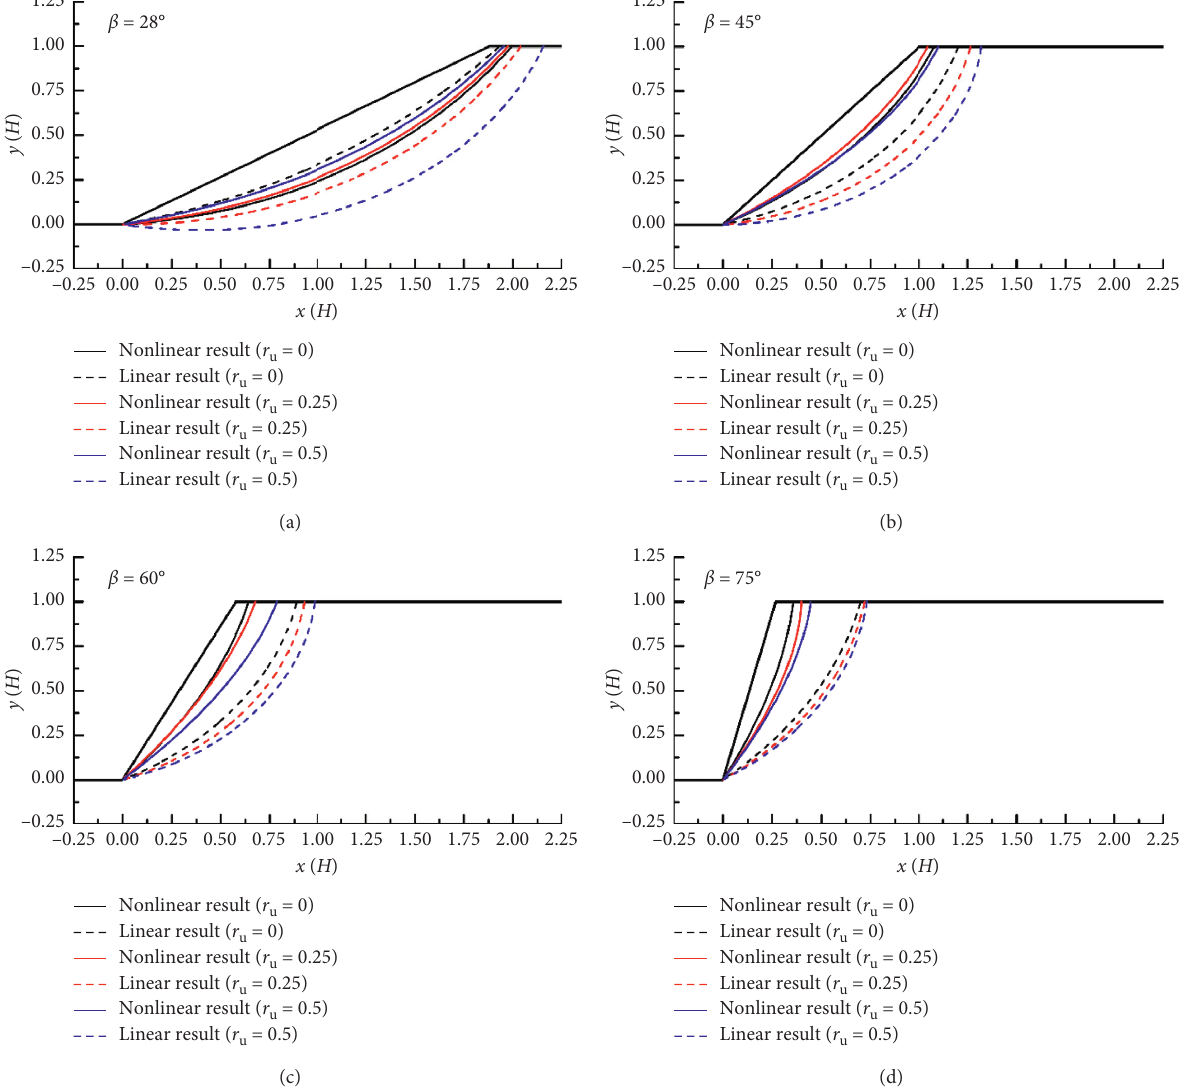
Figure 11: Critical slip surfaces of Israeli clay slopes undergoing different pore-water pressures. (a) β � 28 ° . (b) β � 45 ° . (c) β � 60 ° . (d) β � 75 °